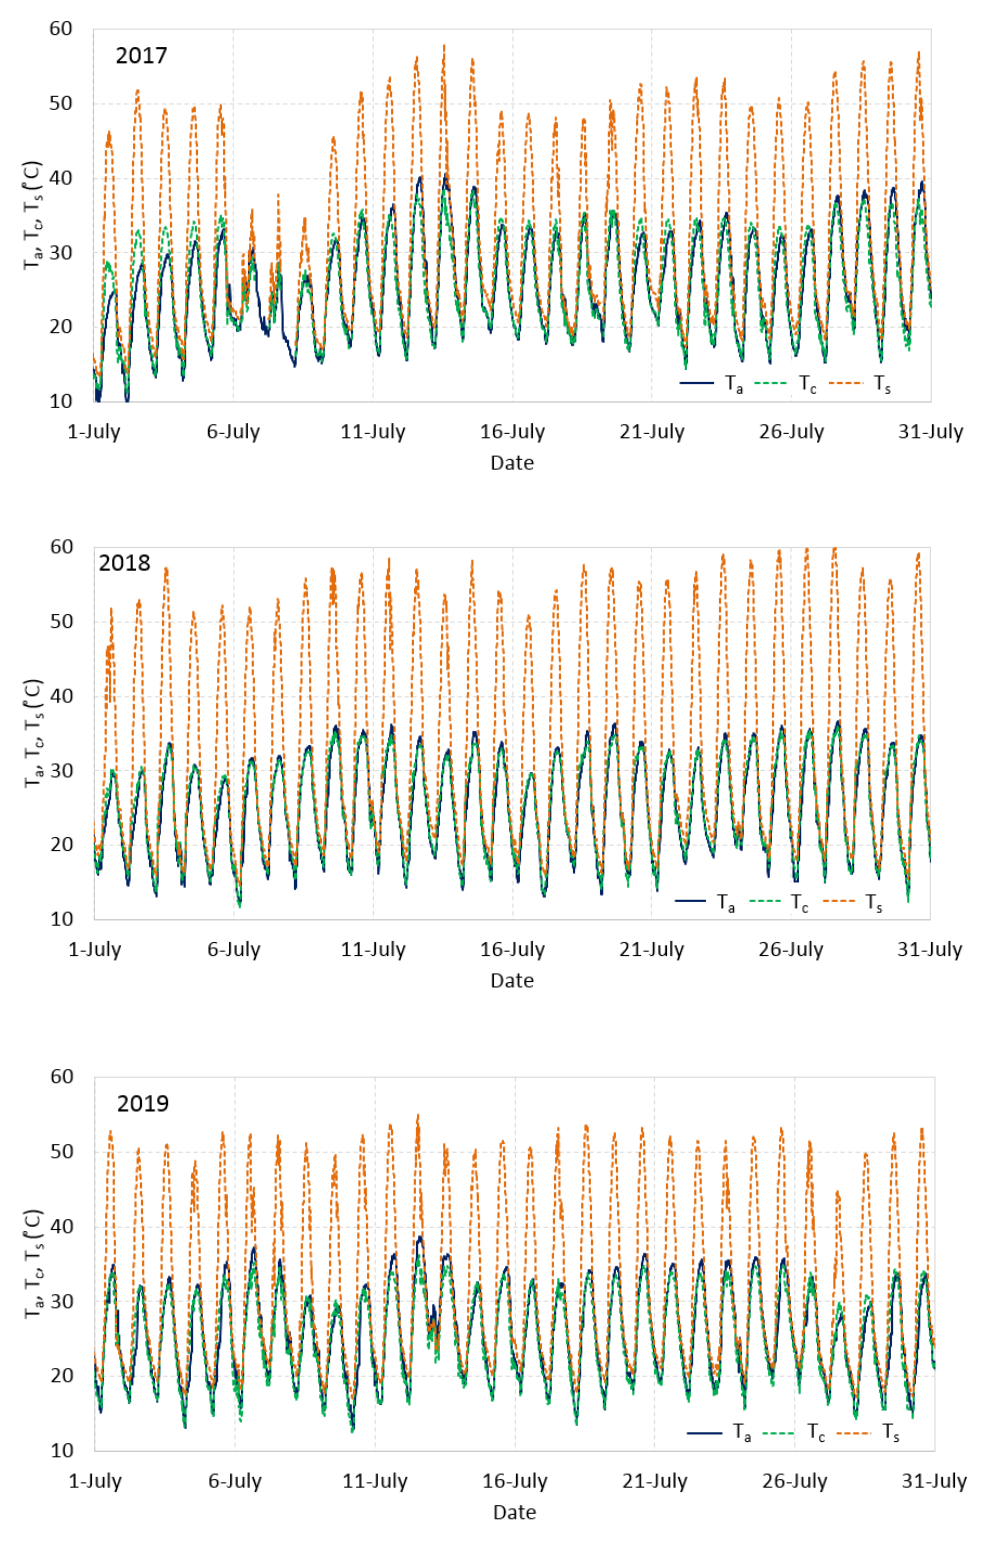
Figure 4. Evolution of soil and canopy radiometric temperatures, T s and T c , respectively, together with the air temperature, T a , for the month of July in the 2017–2019 growing seasons. The model performance evaluation was conducted by using the statistical parameters of the linear regressions (slope, intercept and r 2 ), the root mean square error (RMSE), and the mean bias error (Bias)